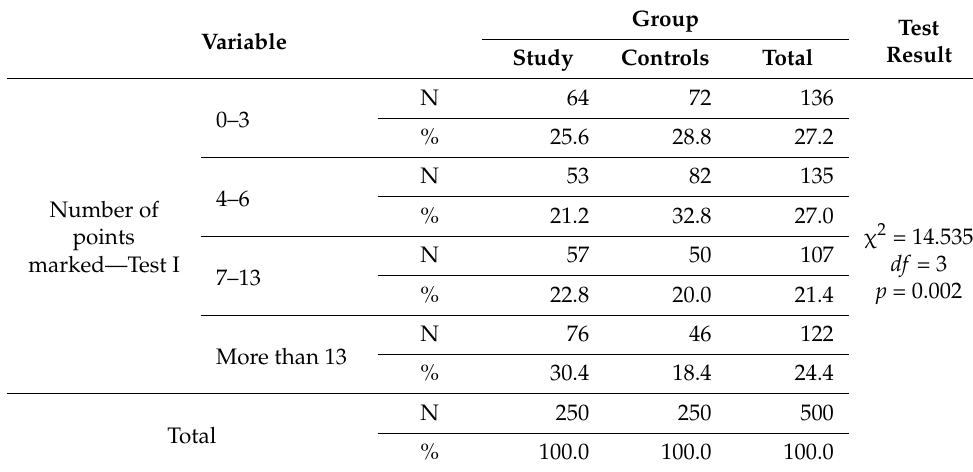
Table 2. Number of points marked on the breast model—Test I. Variable